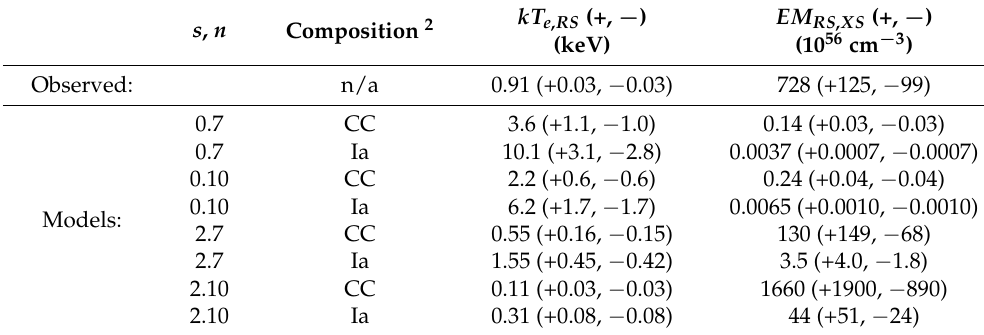
Table 3. SNR J0049-7314: CC and Ia reverse shock models 1